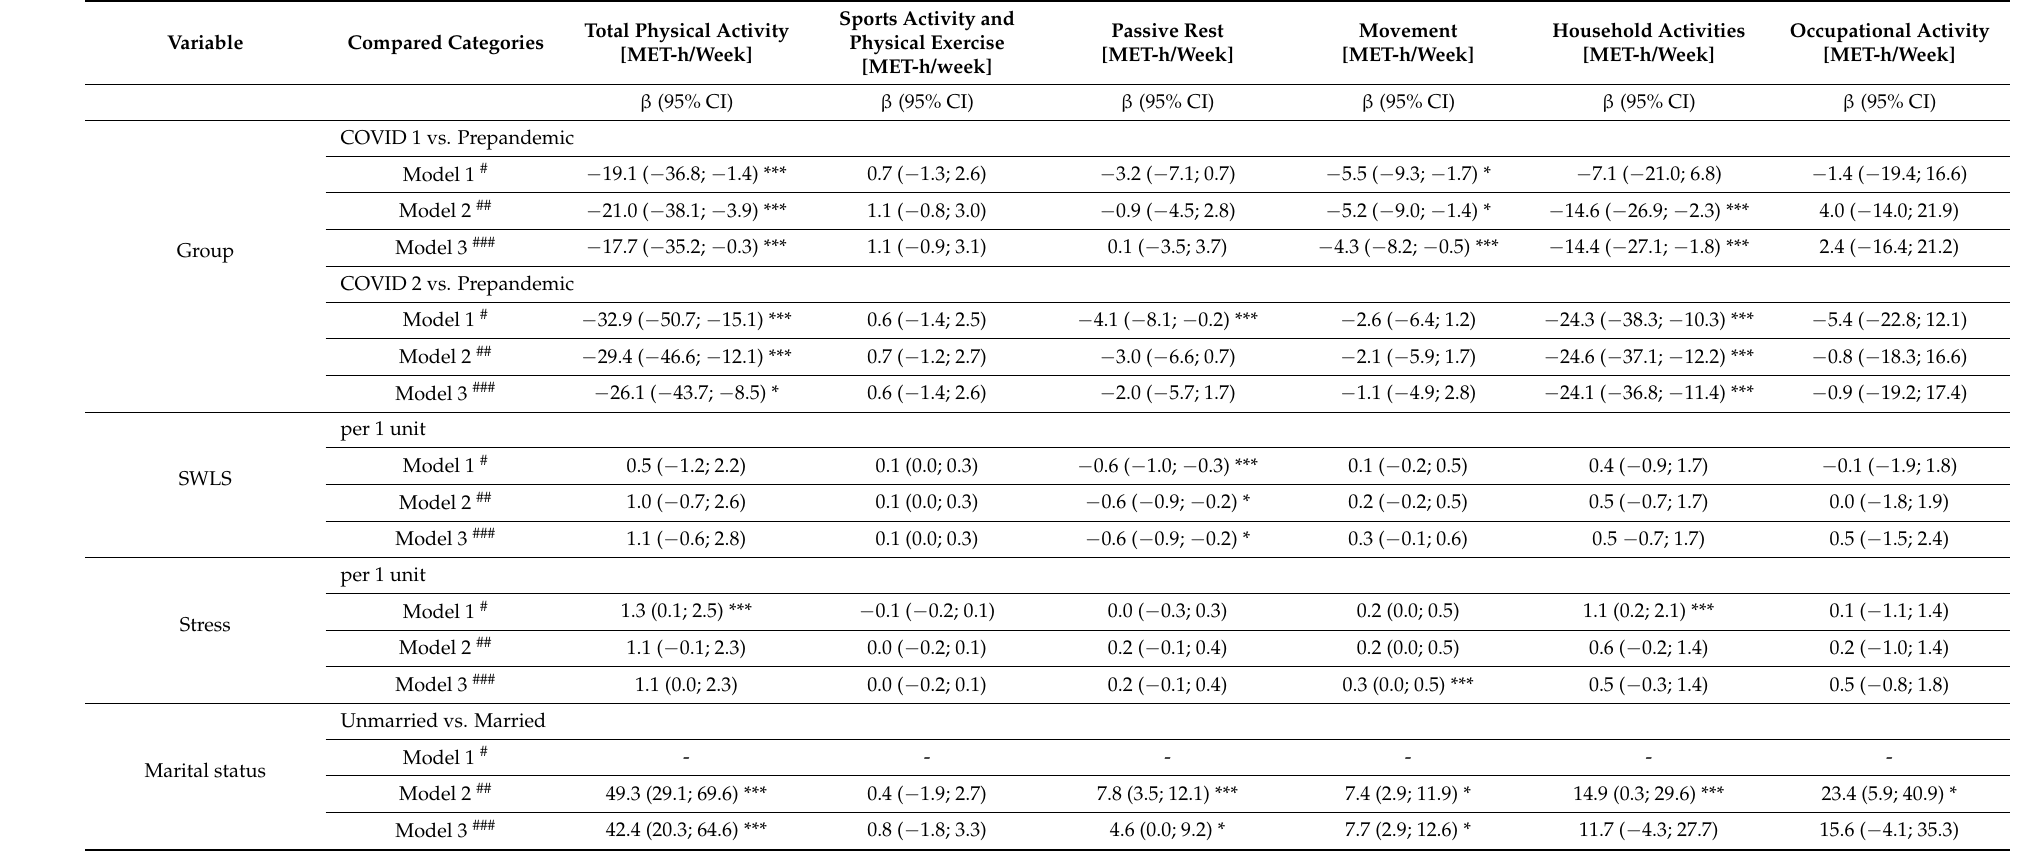
Table 8. Regression